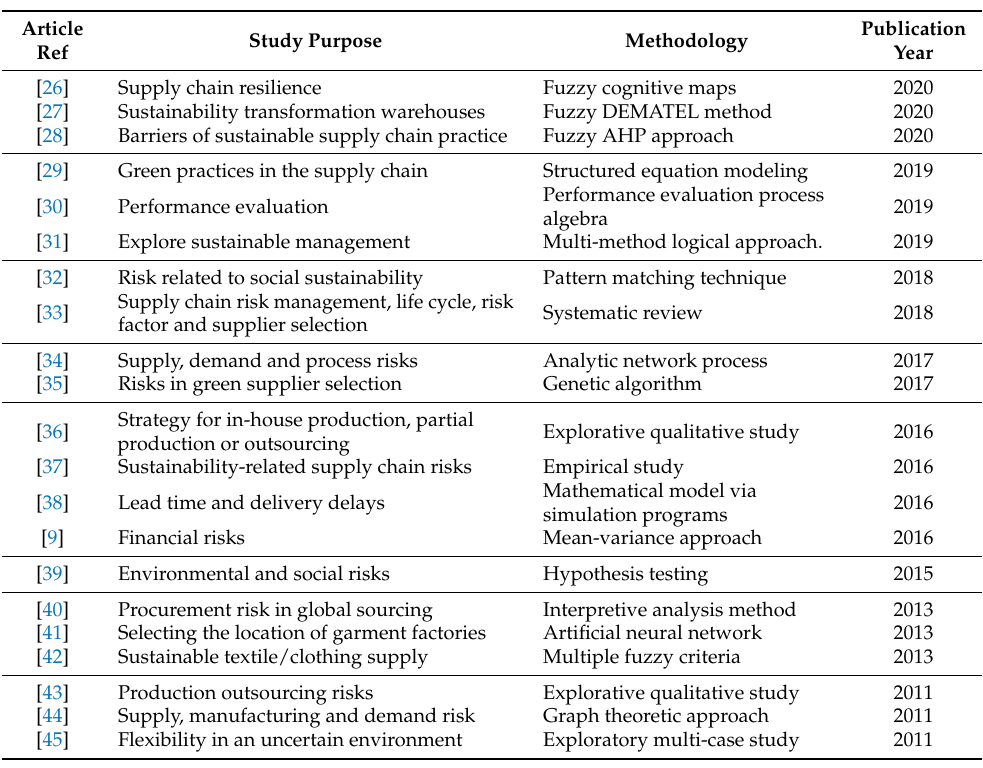
Table 1. Shortlisted research papers as a result of a screening process related to Supply Chain Risk Management in the Apparel Industry Outsourcing as shown in Figure